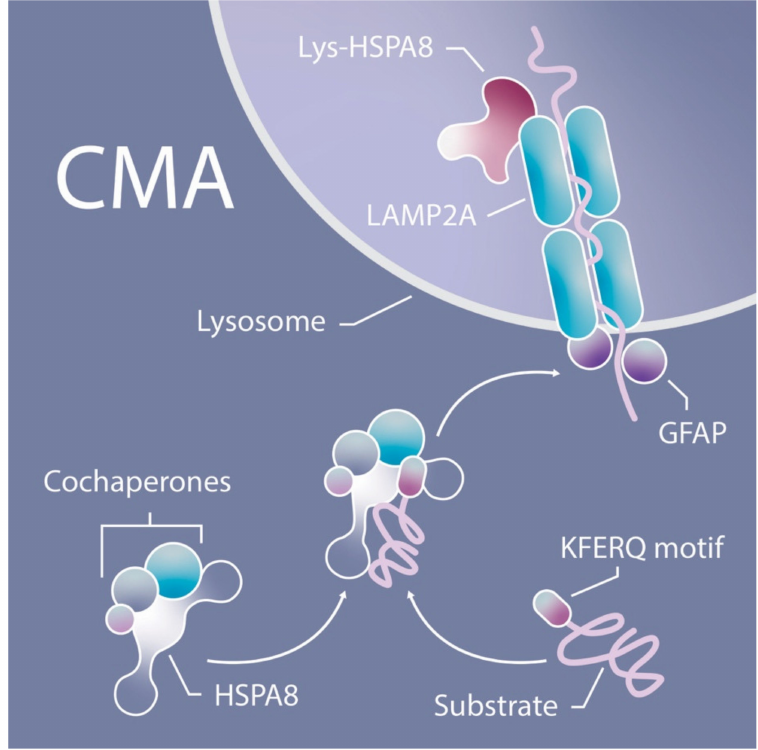
Figure 1. CMA. Substrate transport to the lysosome by HSPA8 and